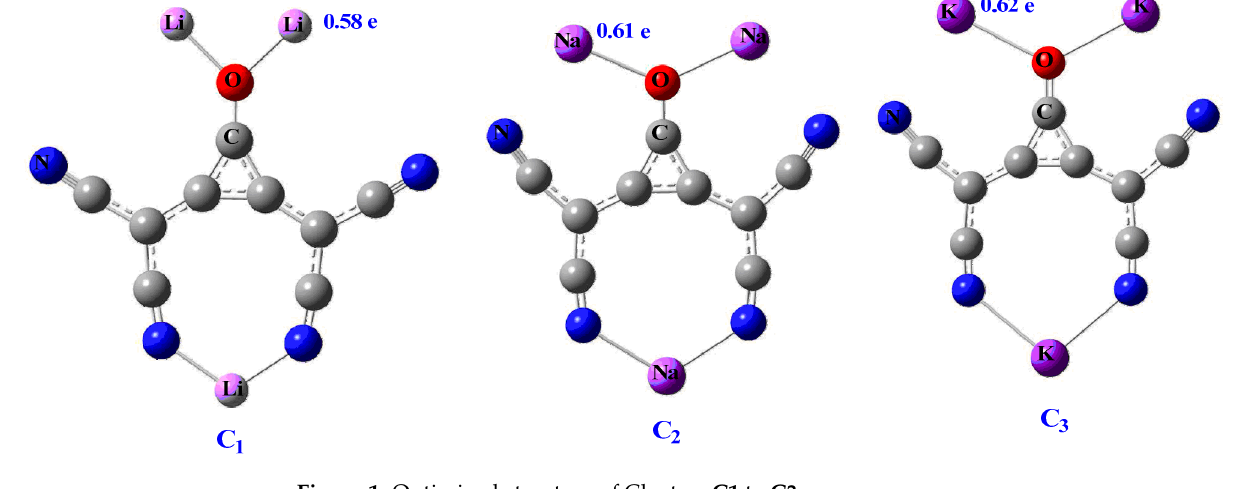
Figure 1. Optimized structure of Clusters C1 to C3 . Table 1. Computed bond length between metal and O-atom (d M-O in Å), the bond length